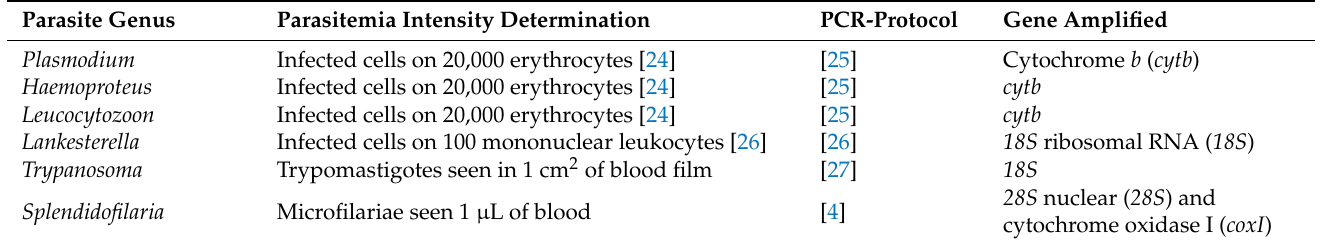
Table 1. Methodology used to determine parasitemia intensity and PCR-protocol applied for DNA amplification of blood parasites found in the Eurasian blackbird ( Turdus merula ) and the Song thrush ( Turdus philomelos